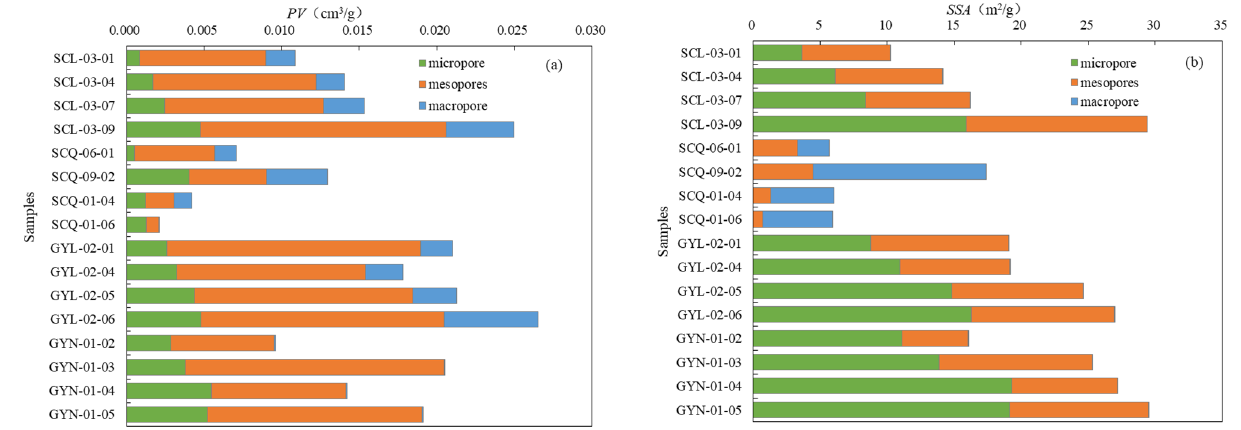
Figure 7. The distribution of PV ( a ) and SSA ( b ) of the Lower Paleozoic shales in the upper Yangtze plate.